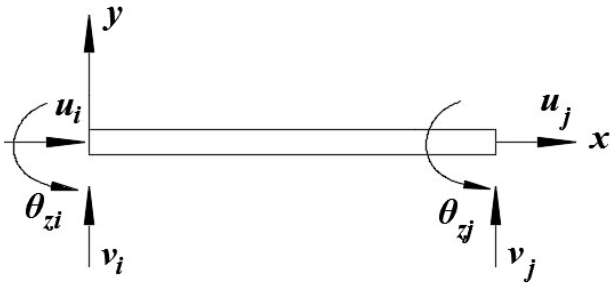
Figure 2. Two-node inverse-beam element.